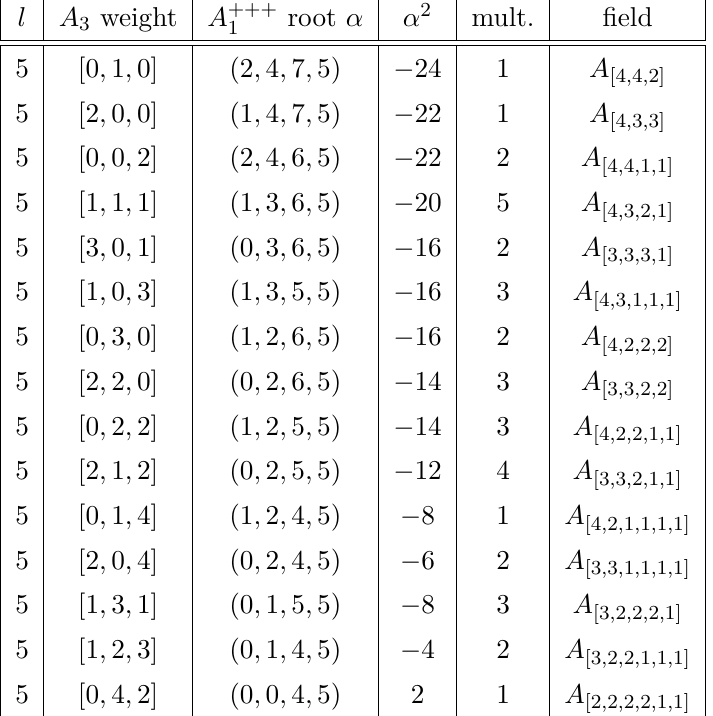
Table 5 . The adjoint representation of A +++